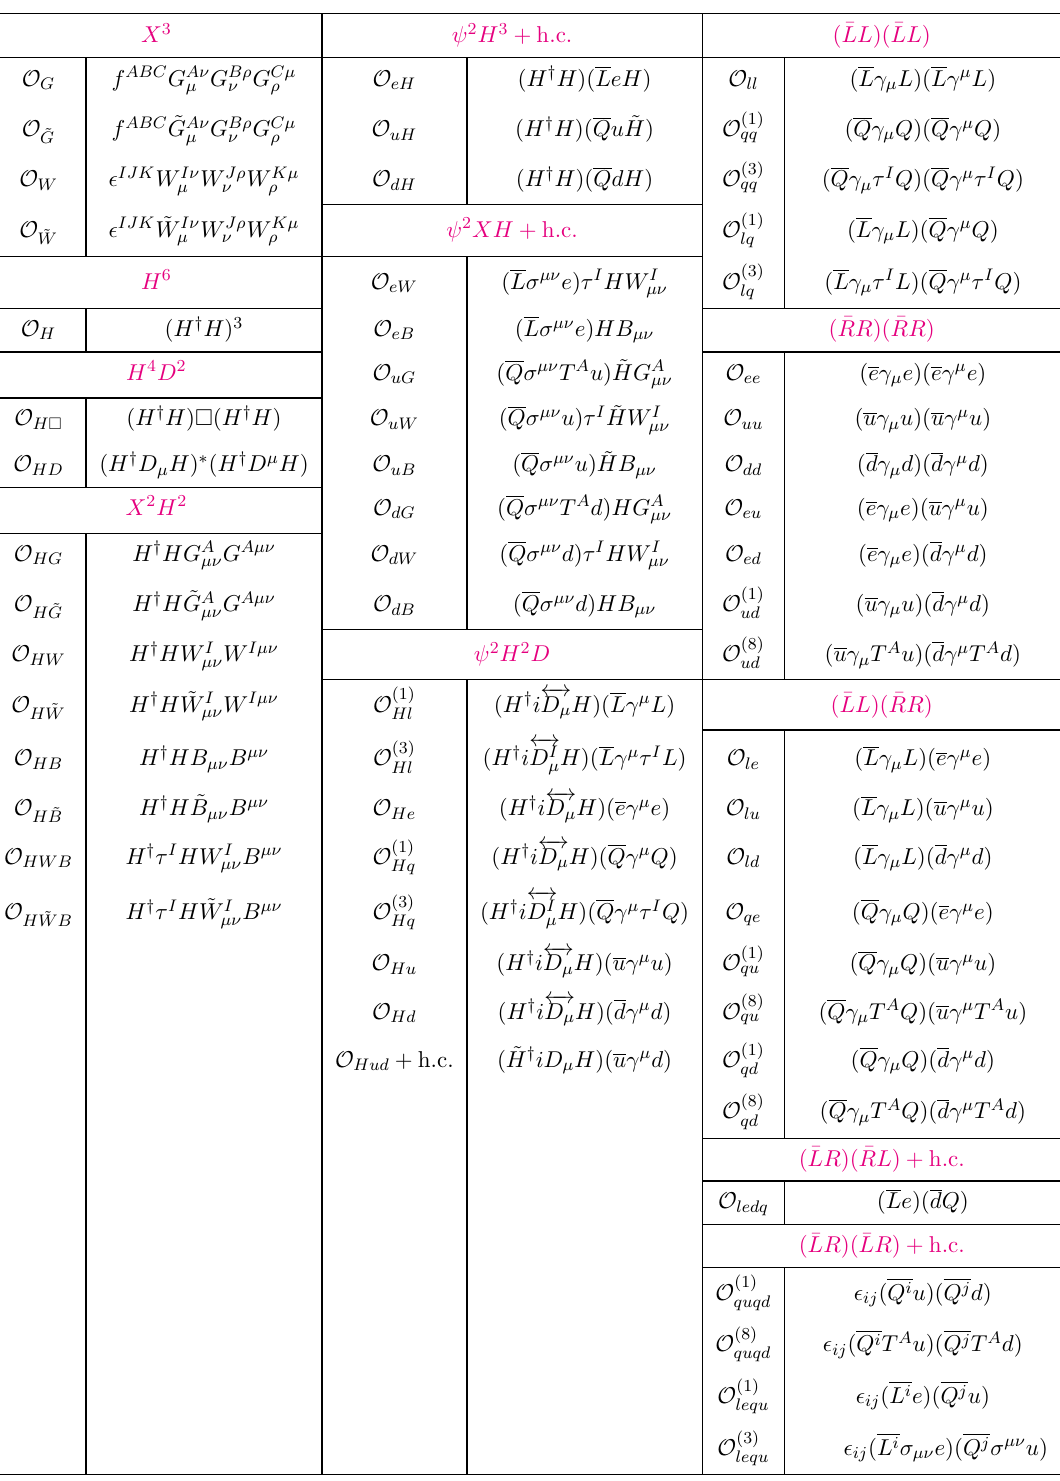
Table 4 . The Warsaw basis of dim-6 operators that conserve baryon and lepton number in SMEFT [26]. Note that in our convention the capital symbols Q and L are used to represent the quark and lepton doublets instead of q and l